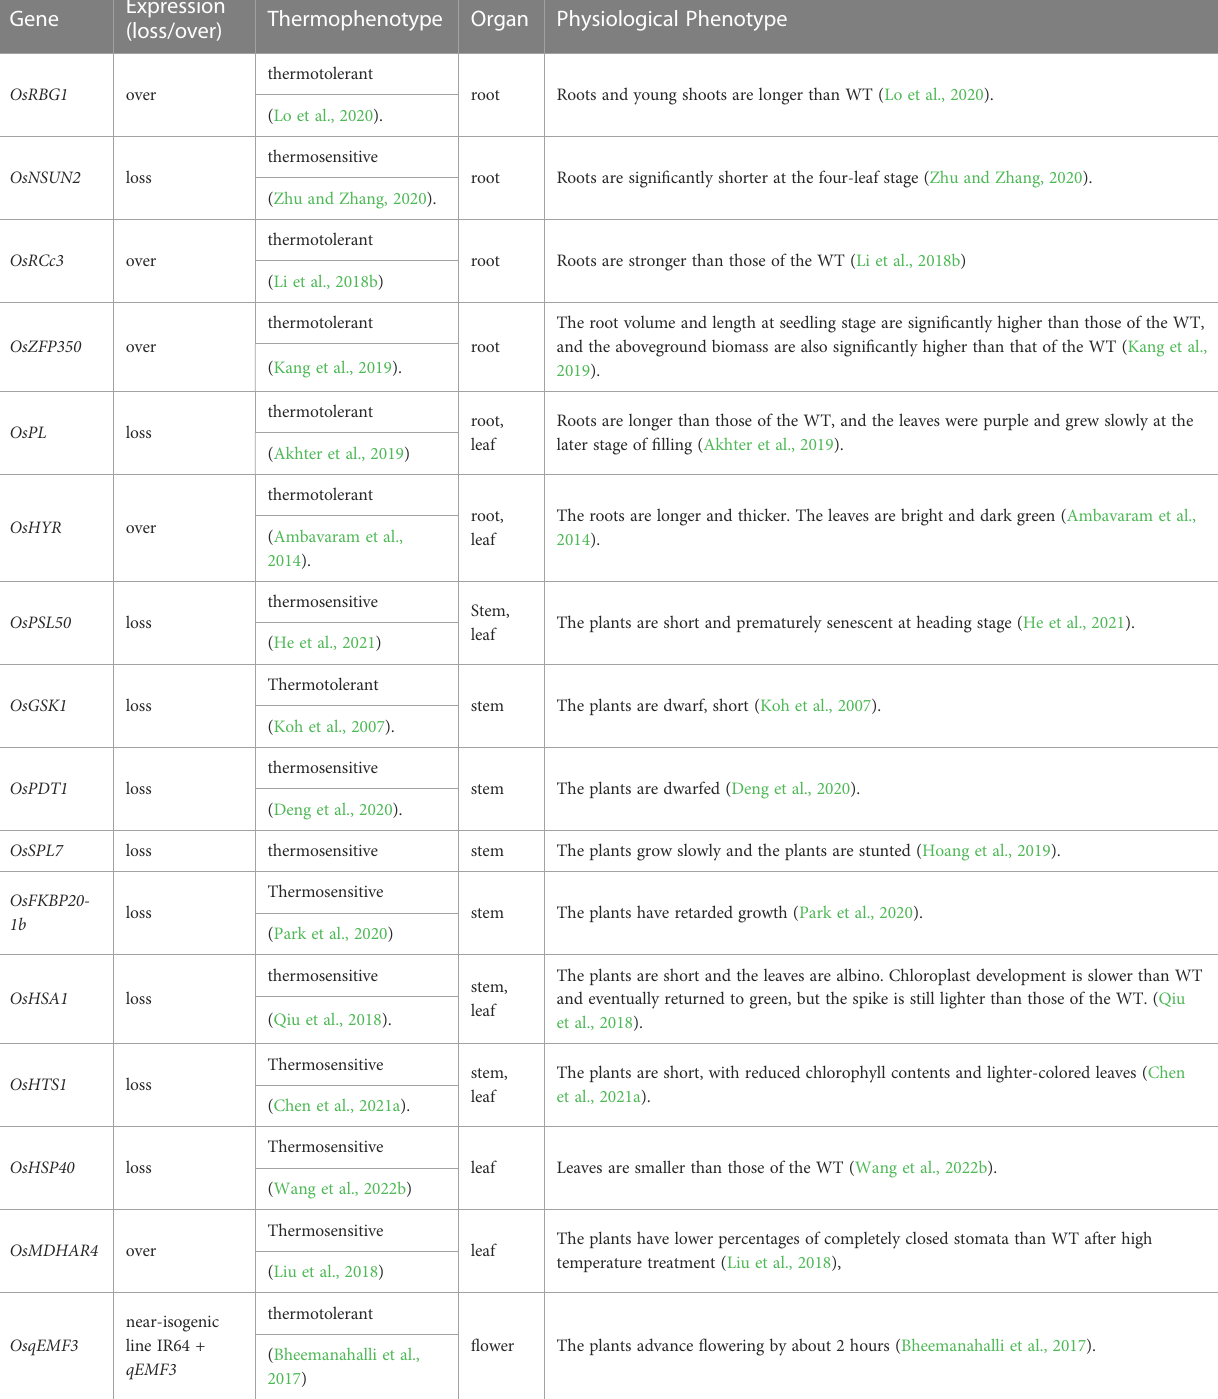
TABLE 1 Thermophenotypes and physiological phenotypes of